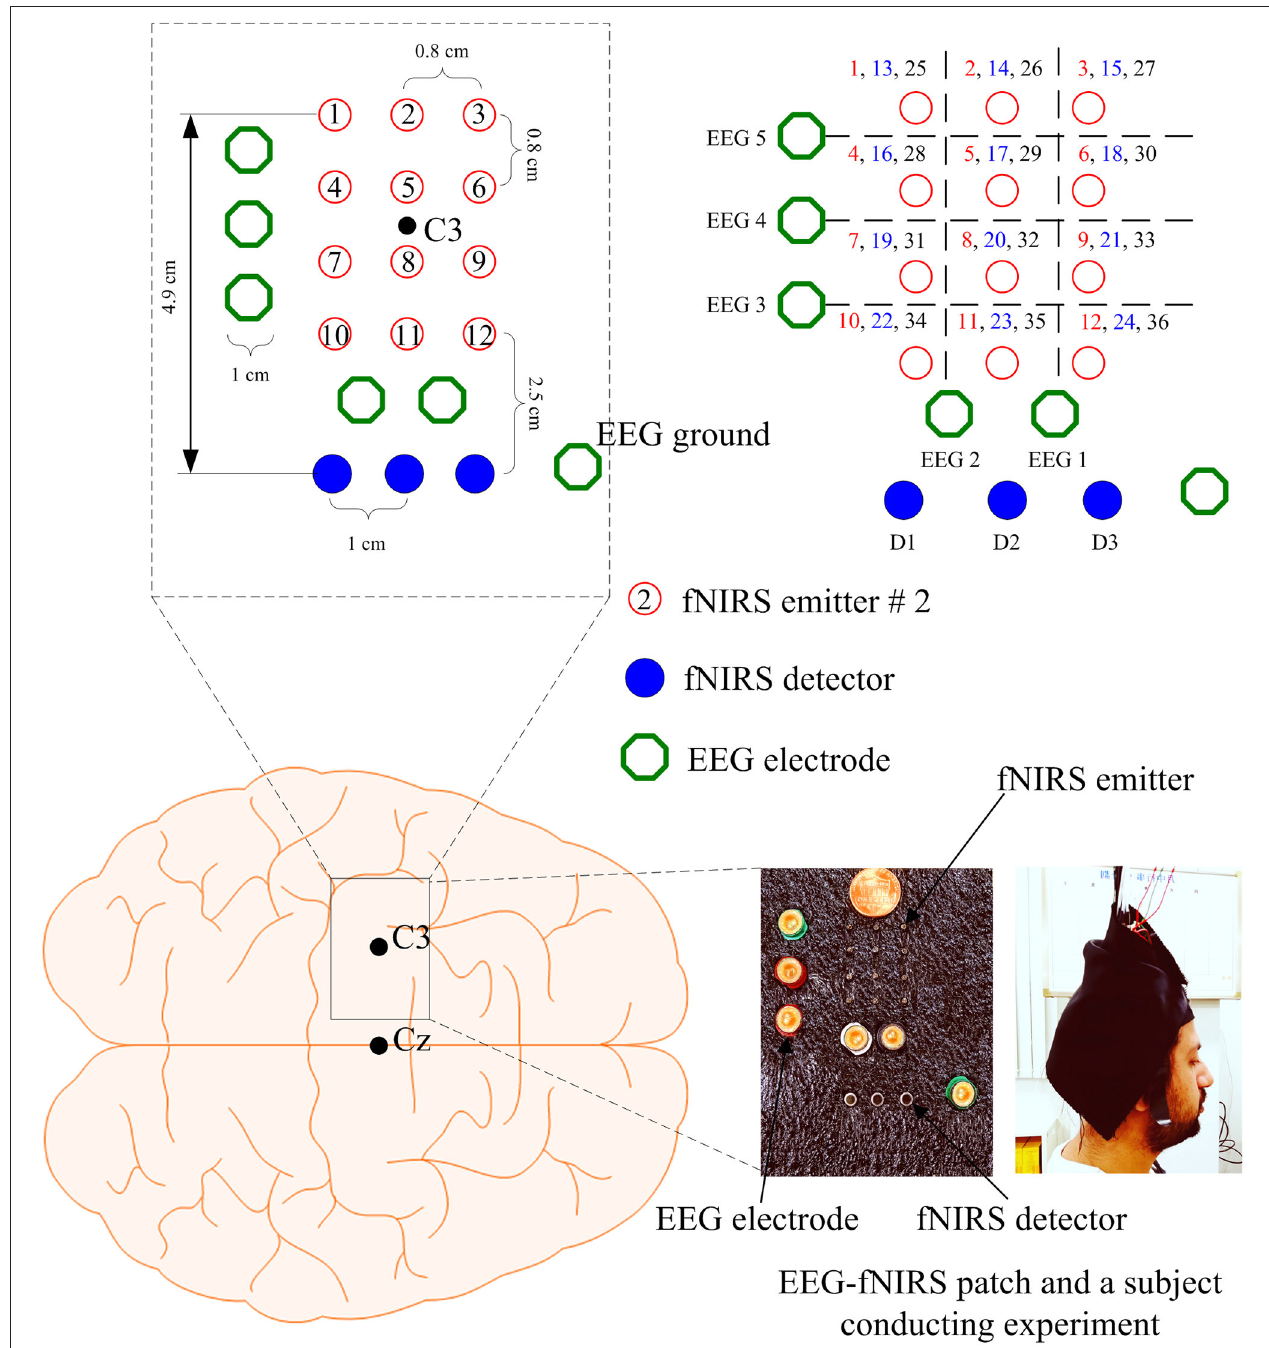
FIGURE 1 | Configuration of EEG electrodes and fNIRS optodes focusing on C3 reference point in the left motor cortex, and photos of EEG-fNIRS patch and a subject performing experiment: the numbers in the top right corner indicate the fNIRS channel